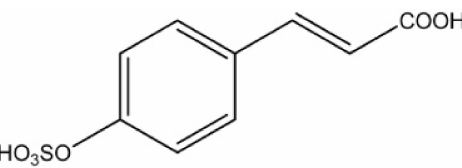
Figure 1. Structure formula of zosteric